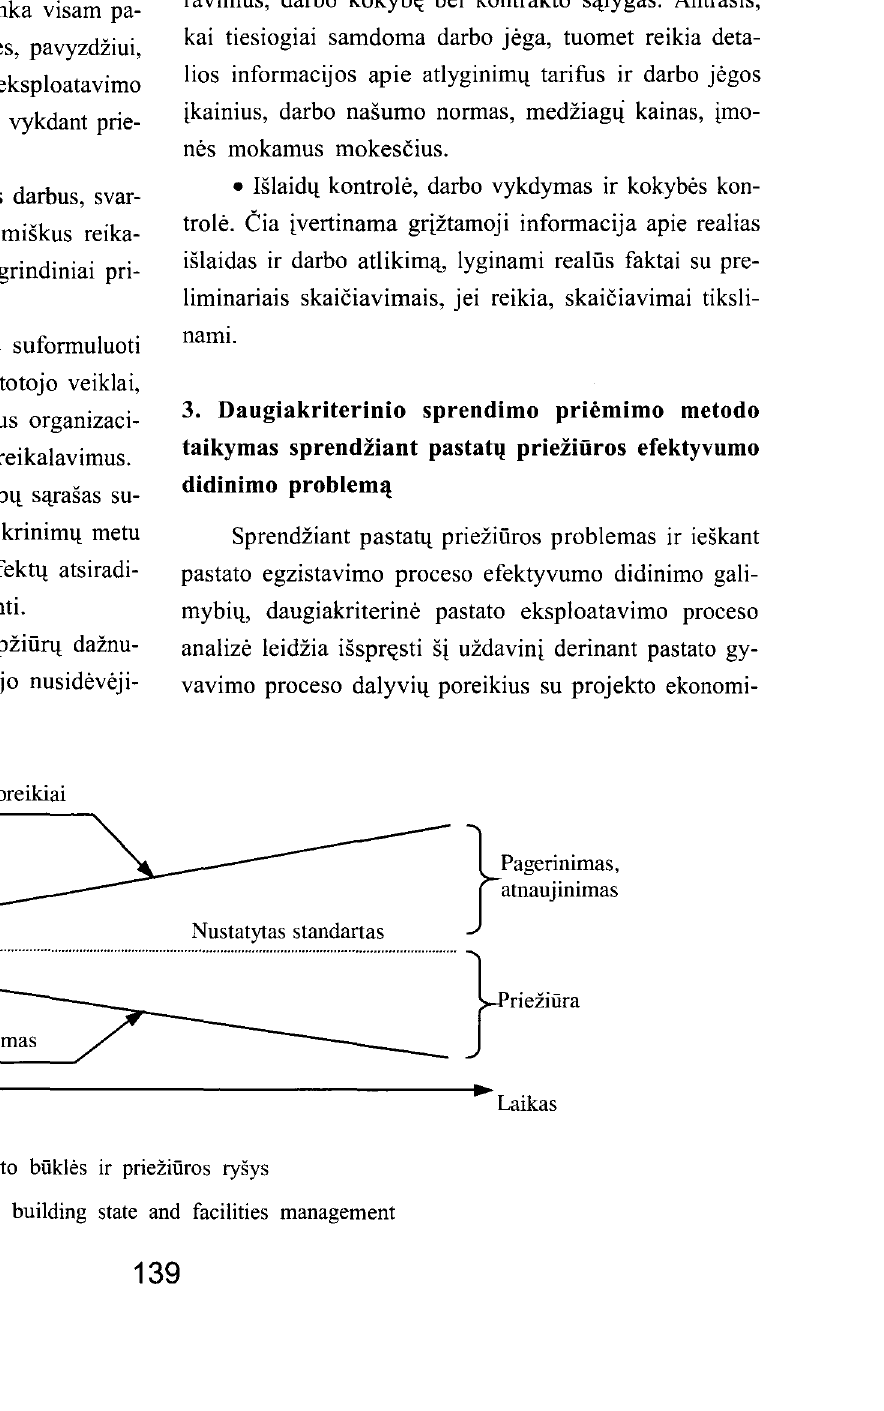
Fig I. Connection between user's needs, building state and facilities